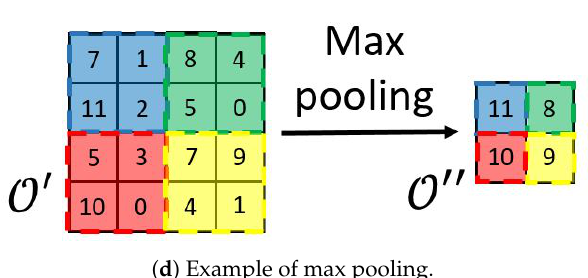
Figure A1. CNN kernel shifting ( a ), scalar products of the convolution operation ( b , c ) and max pooling ( d